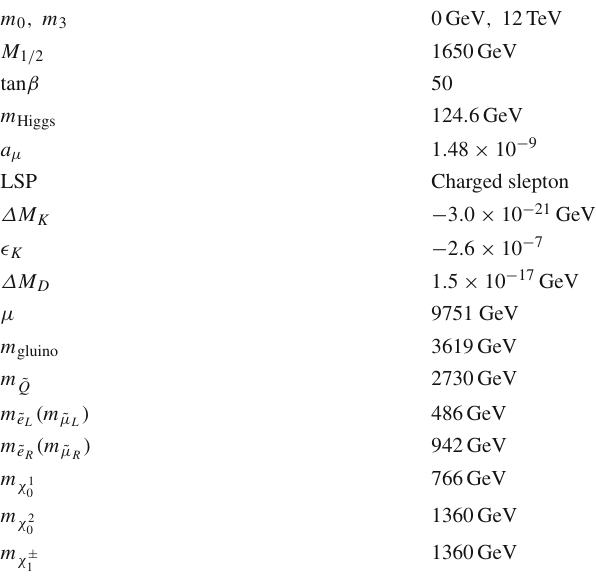
Table 1 A sample point in the universal gaugino mass case. m gluino , m